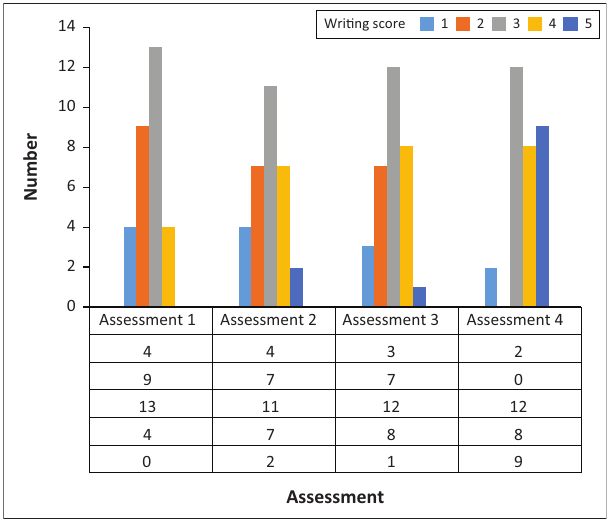
FIGURE 1: Analysis of creative writing assessment tasks.